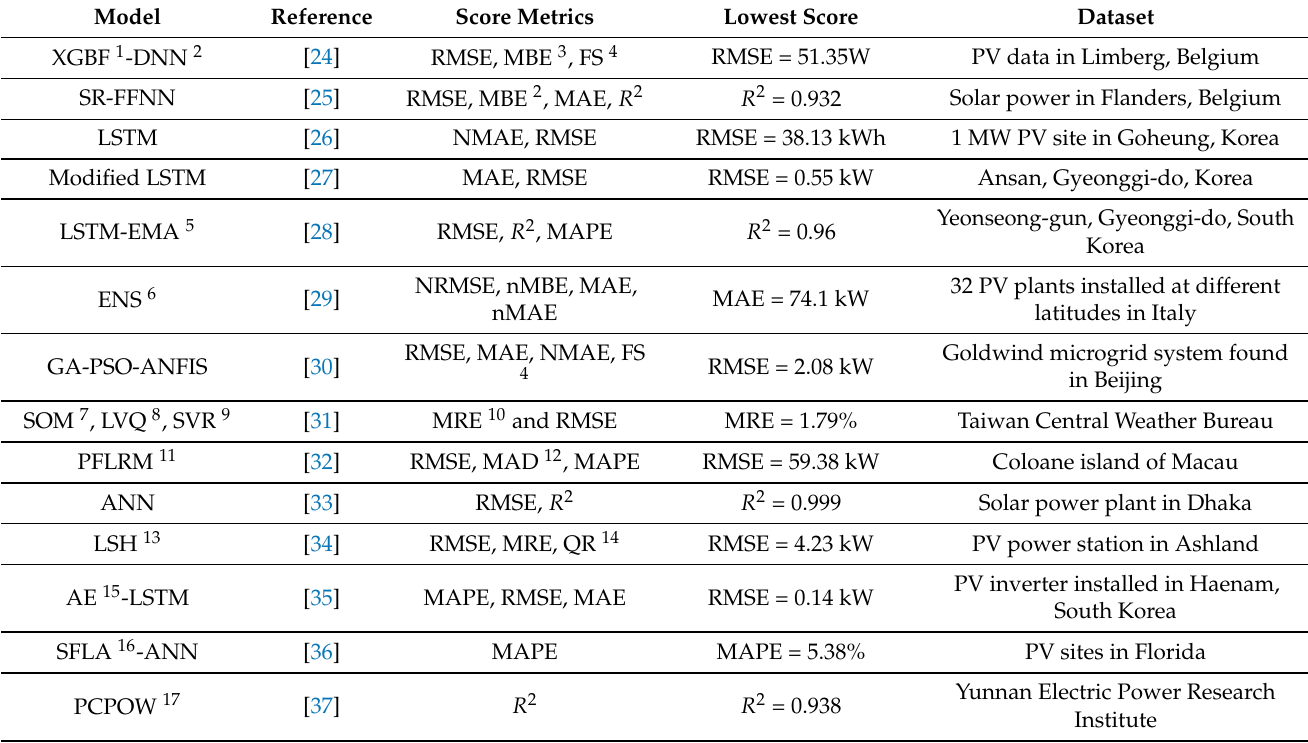
Table 1. State-of-the-art PV power forecasting techniques.